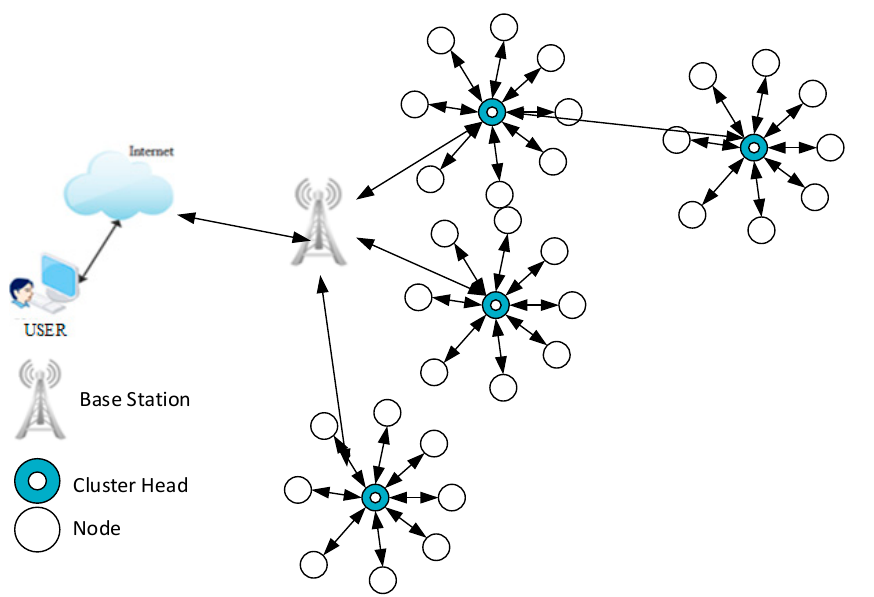
Figure 4. A typical application of a clustered WSN.